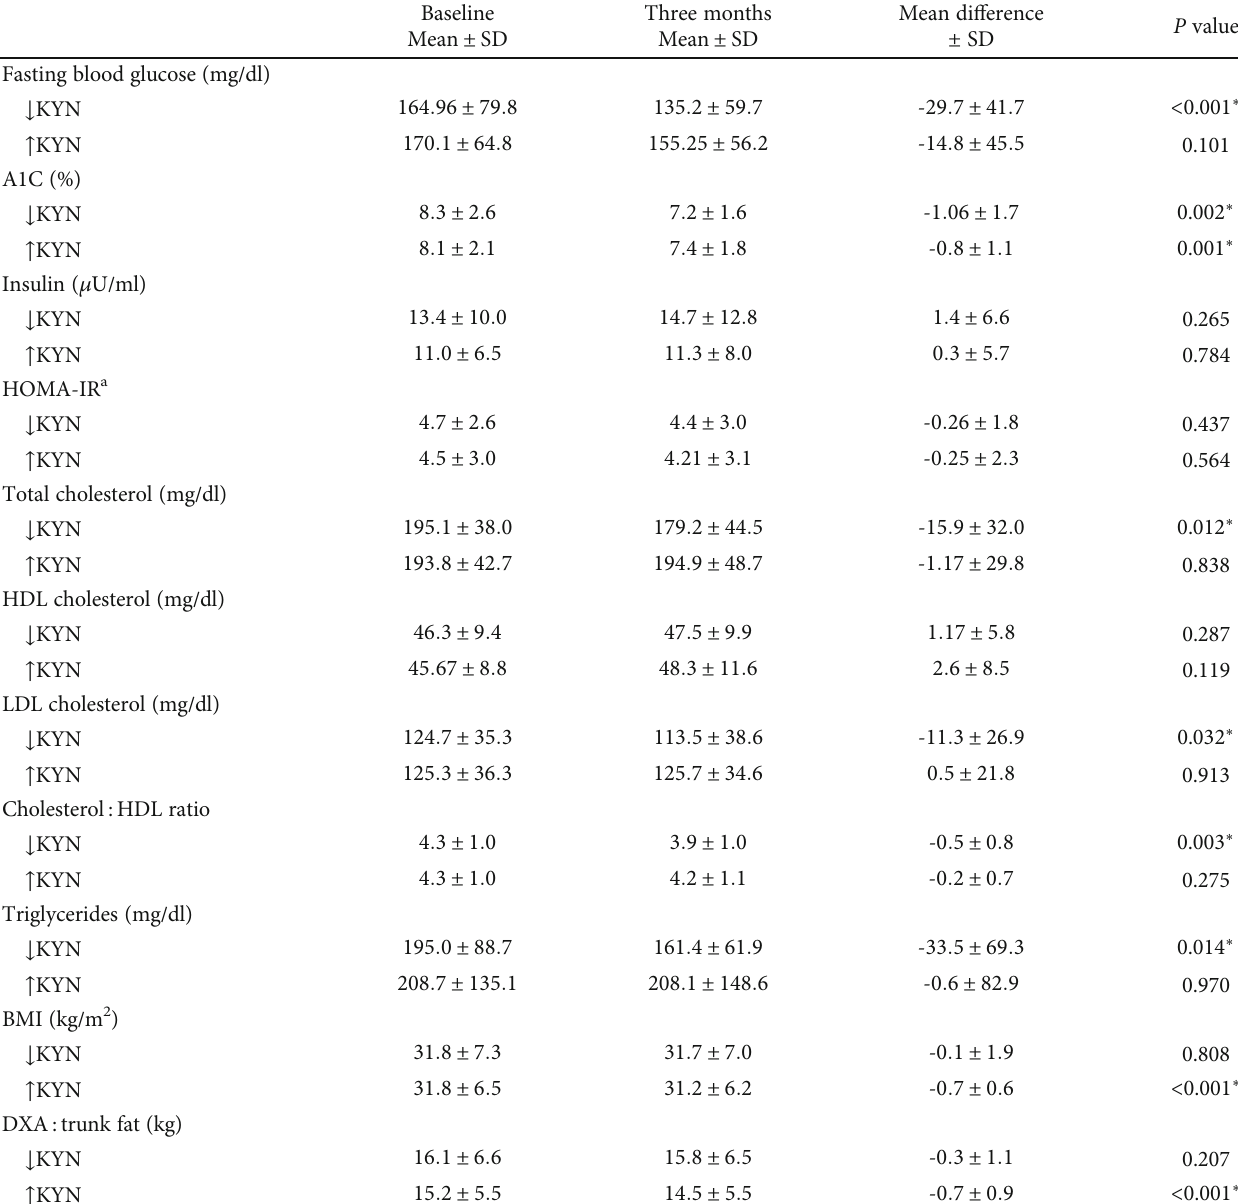
Table 3: Participant blood glucose, lipid, and body composition pro fi les at baseline and at three months ( n = 58 ). Baseline Three months Mean di ff